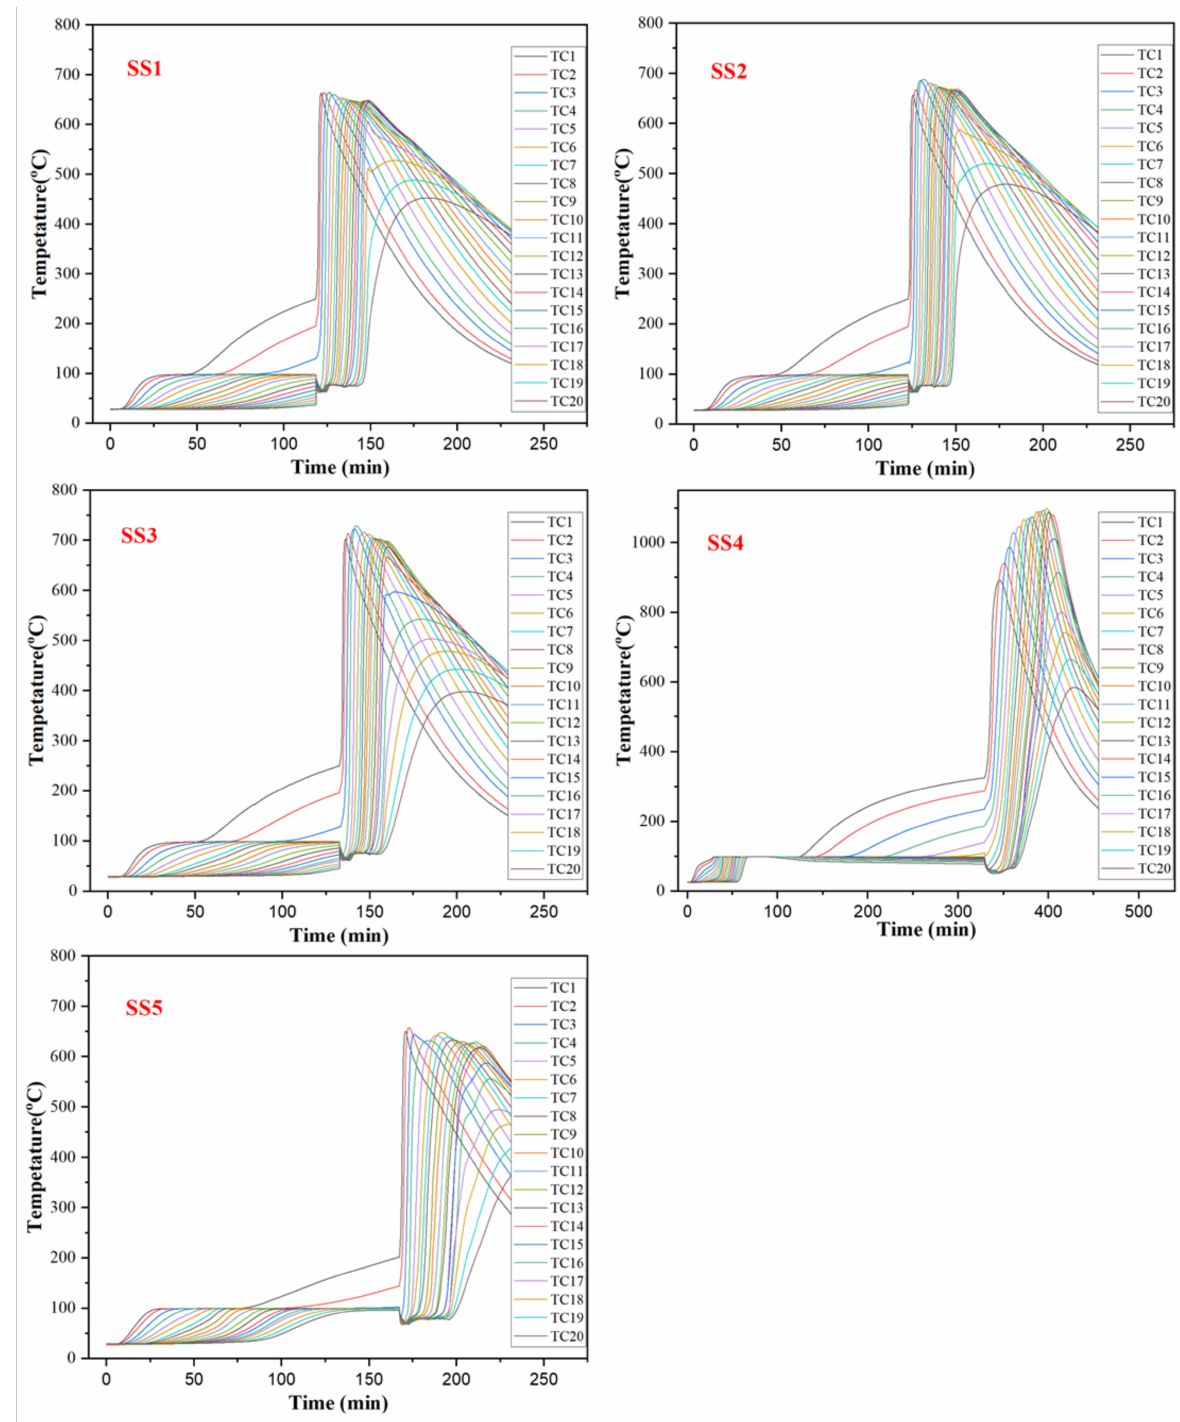
Figure 7. Central temperature histories of smoldering